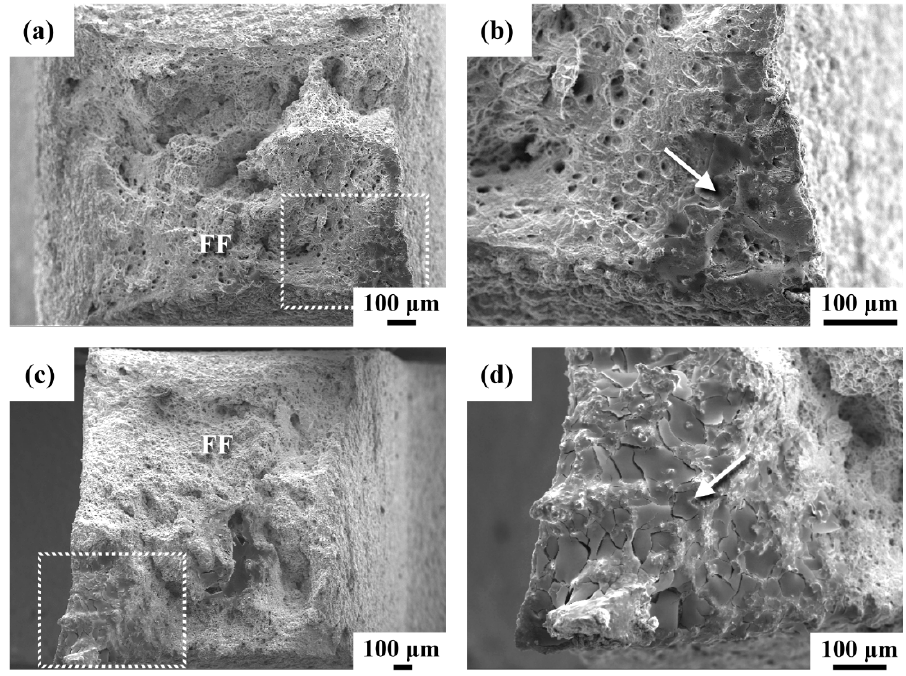
Figure 8. Fracture features of the crept samples: ( a , b ) WT-890T; ( c , d ) WT-820T at 630 ◦ C/120 MPa. Although not all of the tested samples fractured during the creep tests, creep defects could be also induced in the samples. The investigated specimen was cut from the gage section of the sample crept under the 660 ◦ C/80 MPa conditions and subjected to metallographic preparation before inspection. The trace of carbides exhibited the profile of PAGBs. Figure 9 presents the microstructures of the samples before and after the creep loading. Before the creep-straining (Figure 9a,c,e), the precipitates in the original samples were very fine when inspected by SEM, especially in the WT sample. As compared with the initial state, a decrease in carbide density and an increase in carbide size occurred after creep-straining. Coarse precipitates in the WT-820T and WT-890T samples were observed after creep-loading, which implied the degraded creep strength (Figure 9d,f). The high density of carbides decorating the grain boundaries of the WT-890T sample revealed its fine-grained structure (Figure 9e,f). Under the creep-straining, microcracks were prone to be induced at the corners of the tested sample (Figure 9b,d,f), which propagated mainly along the grain boundaries. According to the carbide distribution, the coarse-grained structure was maintained in the WT and WT-820T samples (Figure 9b,d), but a fine-grained structure was found in the WT-890T sample (Figure 9f) after the creep tests.